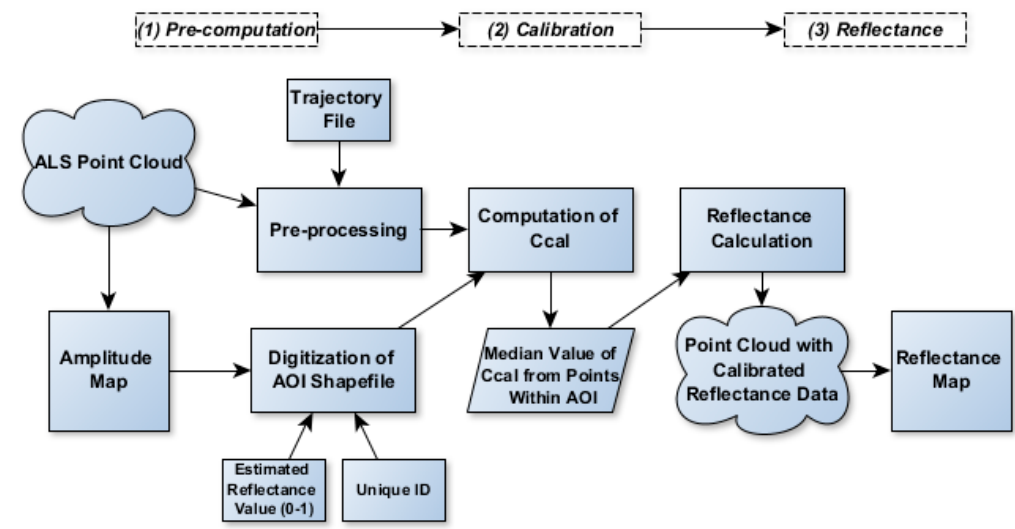
Figure 4. Workflow for relative calibration of reflectance data.